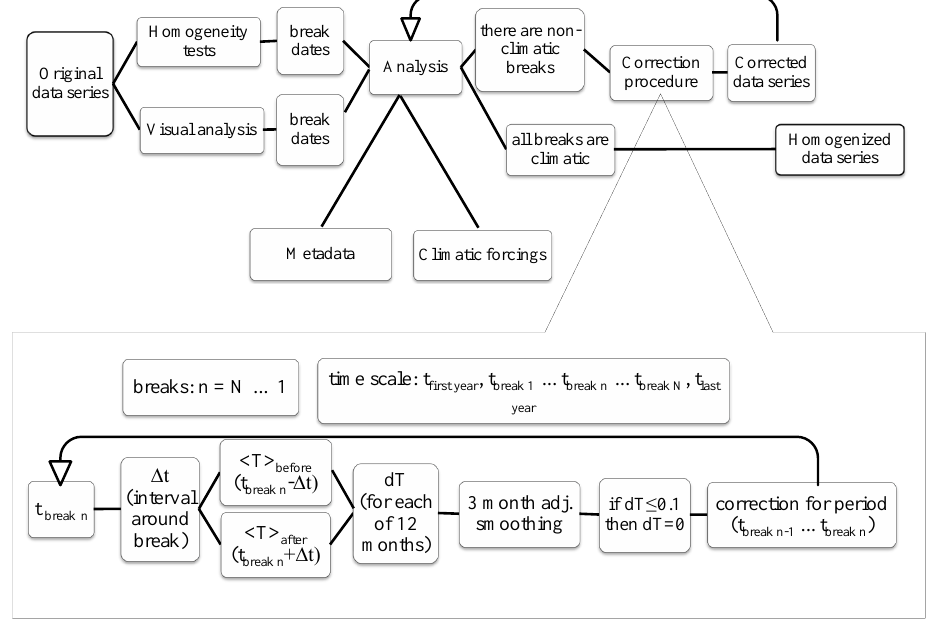
Figure 1. Homogenization procedure. Top – main procedure. Bottom – correction procedure for known non-climatic